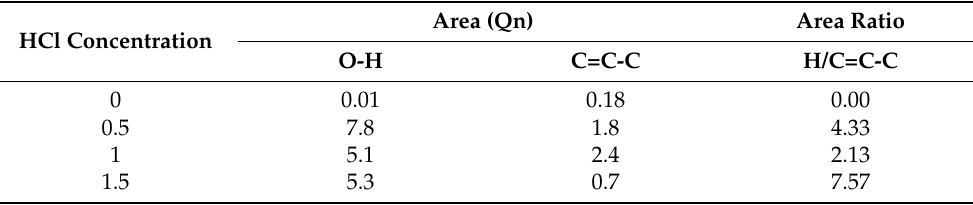
Table 1. Deconvolution of O-H/C=C-C concentration.